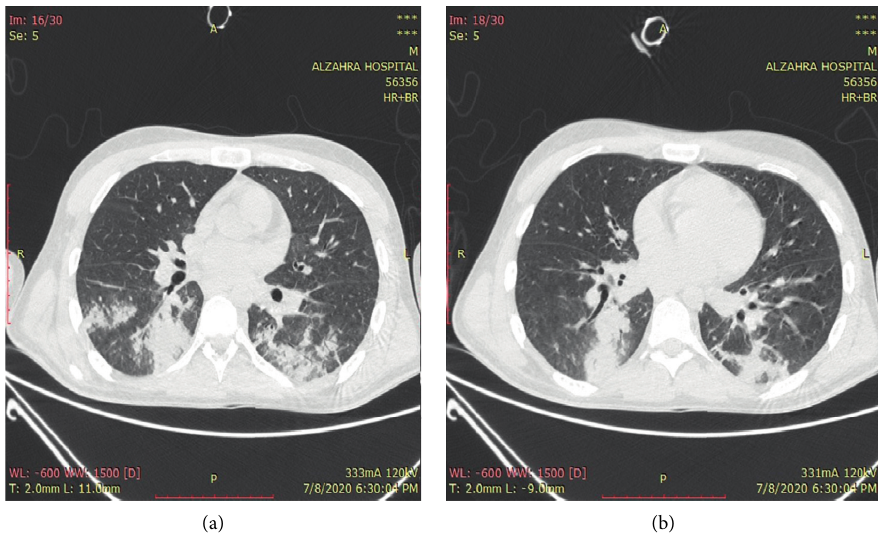
Figure 1: Multifocal peribronchial consolidation and diffuse ground-glass opacities.